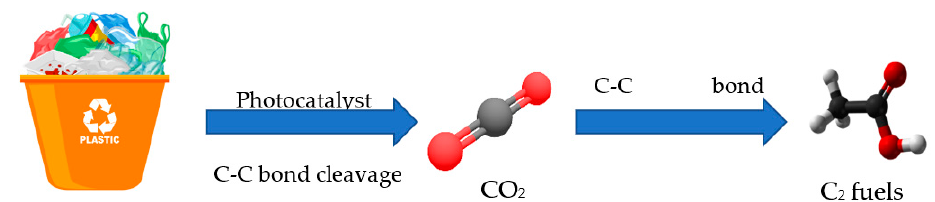
Figure 4. Photocatalytic oxidation of plastic waste.